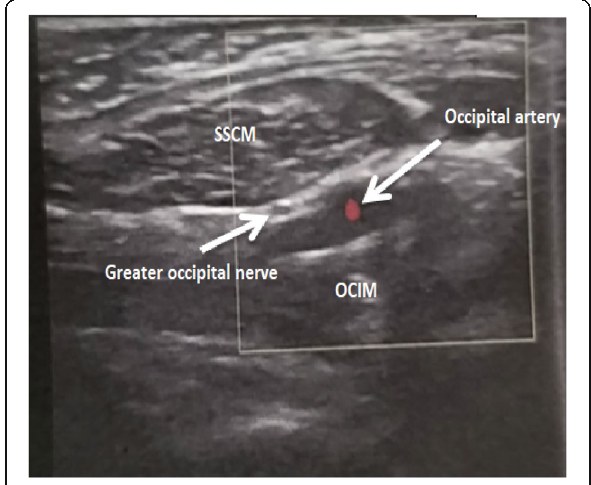
Fig. 1 Ultrasound imaging of the dorsal neck with color Doppler shows greater occipital nerve and occipital artery (white arrows), semispinalis capitis muscle (SSCM), and obliquus capitis inferior muscle